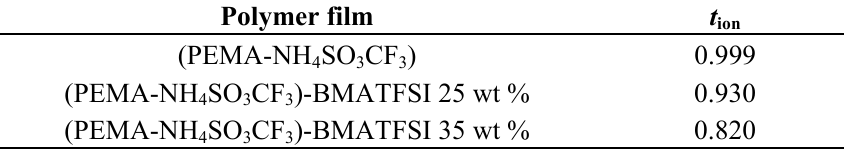
4. Ionic transference number of PEMA-NH electrolyte